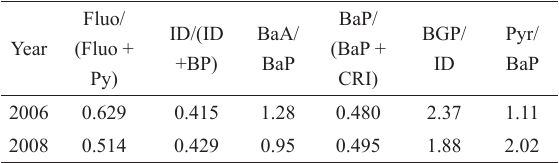
PAHs ratios for the years 2006 and 2008.